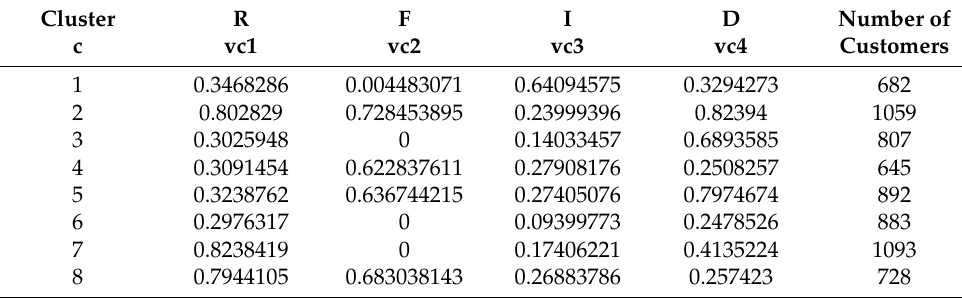
Table 11. Result of the k-Means Algorithm.